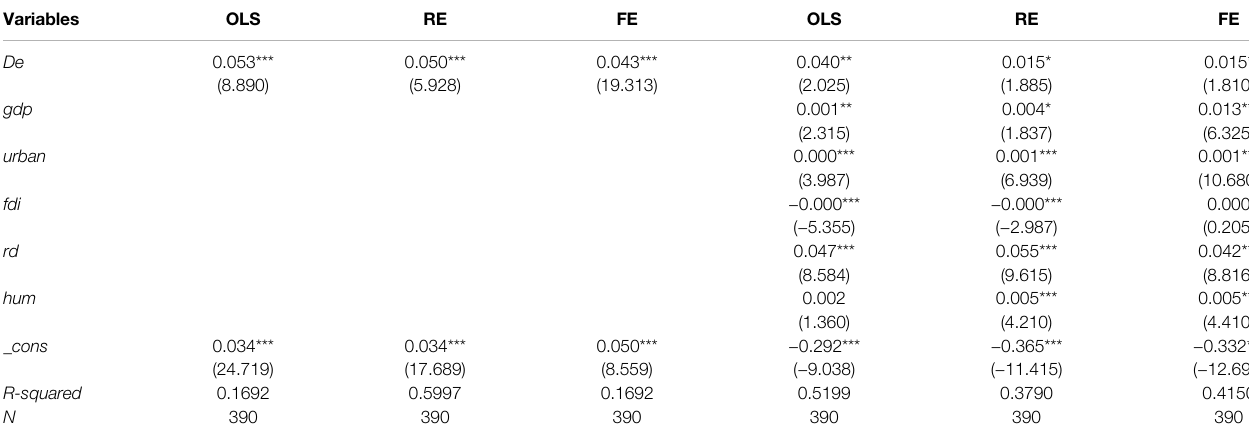
TABLE 4 | Robustness test results (replacing core variables).